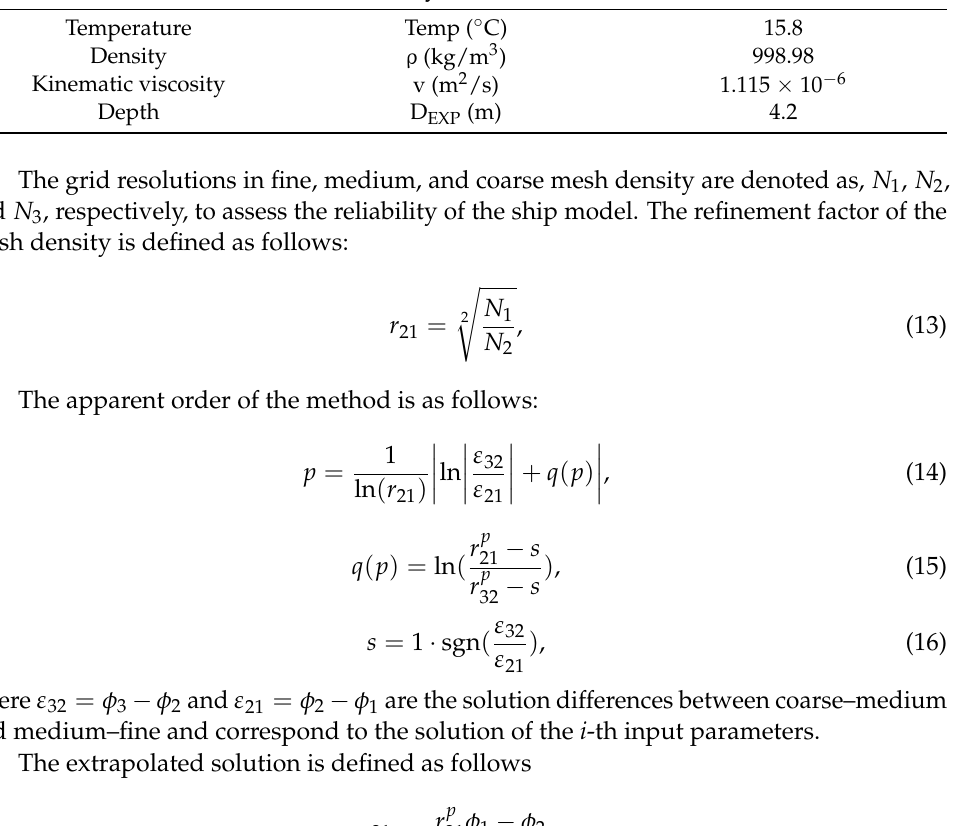
Table 3. Parameters of experimental setup.